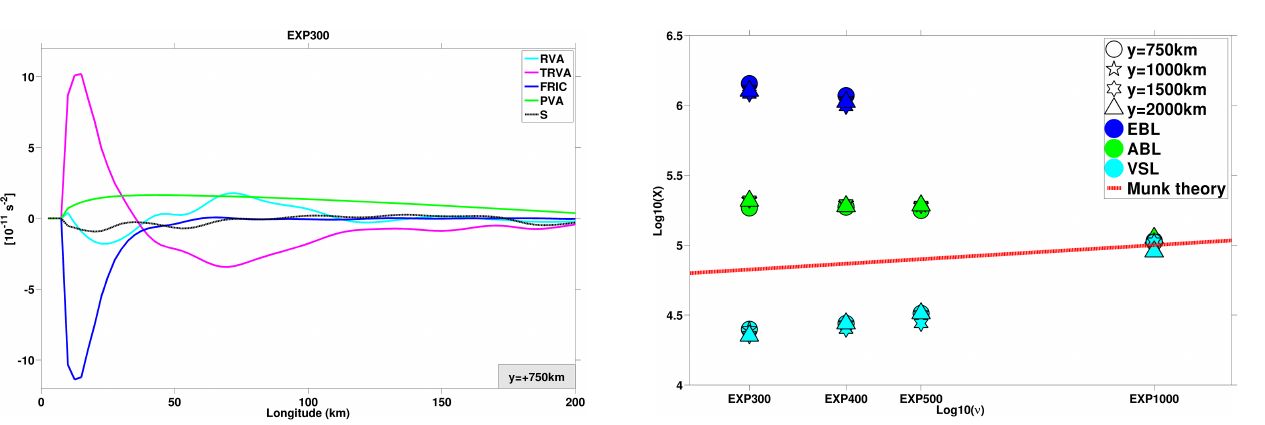
Figure 5. Vorticity balance. Different terms of Eq. (14) are plotted for the lowest viscosity experiment EXP300 at y = + 750km. The different terms of Eq.(14) plotted correspond to the relative vorticity advection (RVA; terms 1 and 2), turbulent relative vorticity advec- tion (TRVA; terms 3 and 4), planetary vorticity advection (PVA; term 5), friction (FRIC; term 7) and S comprises forcing, stretching and residual time dependence.